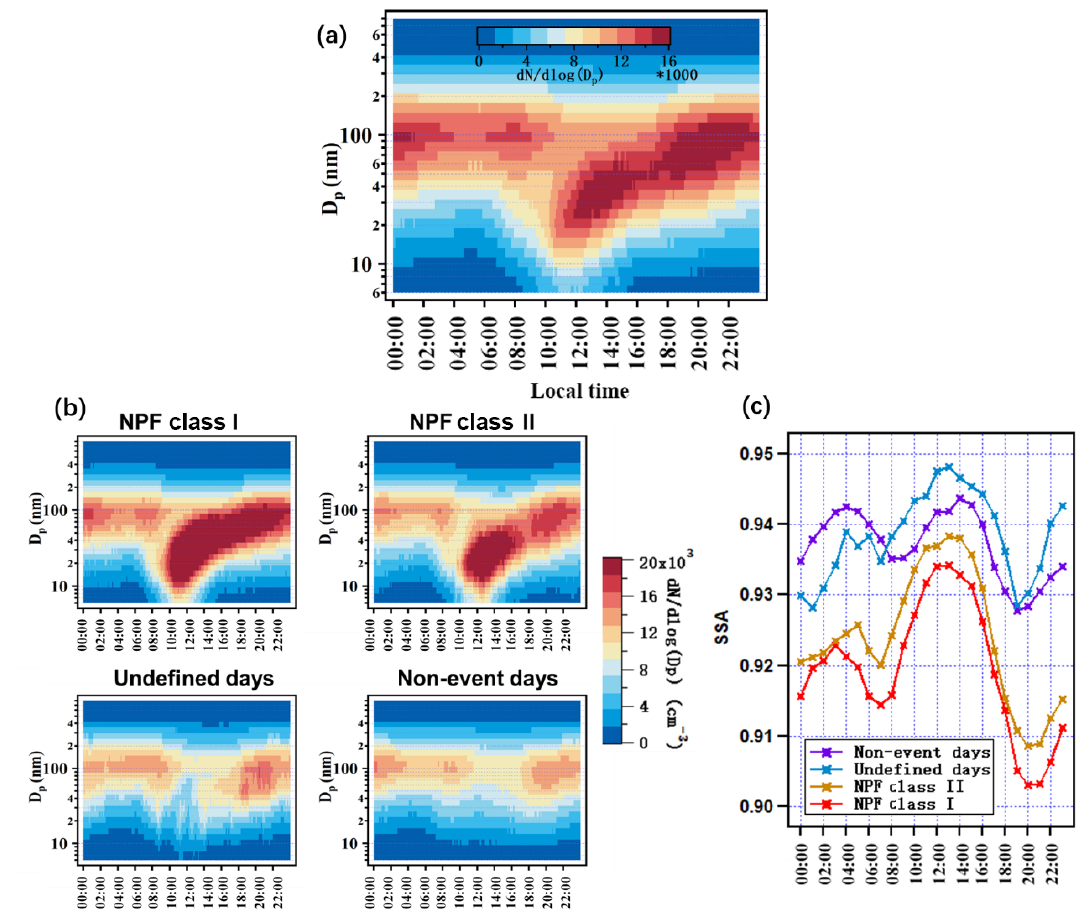
Figure 5. Diurnal cycles of particle number size distributions and SSA classified into NPF classes. (a) Averaged particle number size distribution of the whole measurement period, (b) diurnal number size distributions averaged over NPF class I and NPF class II days, undefined days, and non-event days, and (c) average diurnal cycle of SSA by using the dates classified as in the NPF